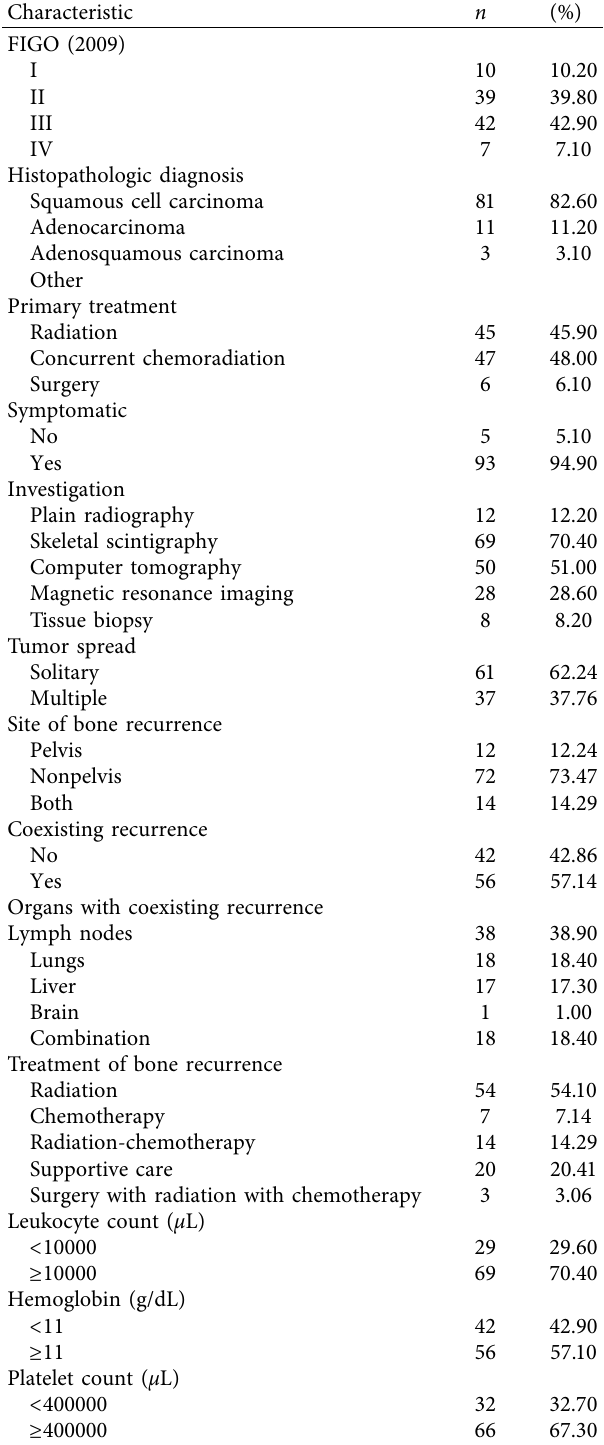
FIGO stage, International Federation of Gynecology and Obstetrics Staging System